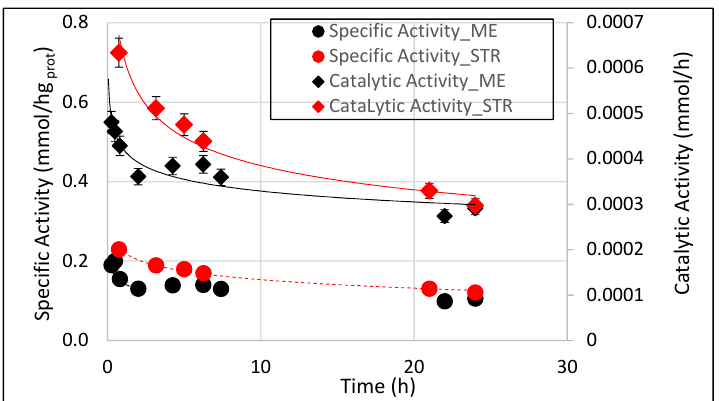
Figure 6. Time course of specific activity and catalytic activity of lipase distributed at the oil/water interface by membrane emulsification (ME) and stirring tank reactor (STR). Table 2. Enantiomeric excess, conversion, and specific activity measured in enantioselective hy- particles interface produced by membrane emulsification (ME) and stirring method after 24 h of reaction.